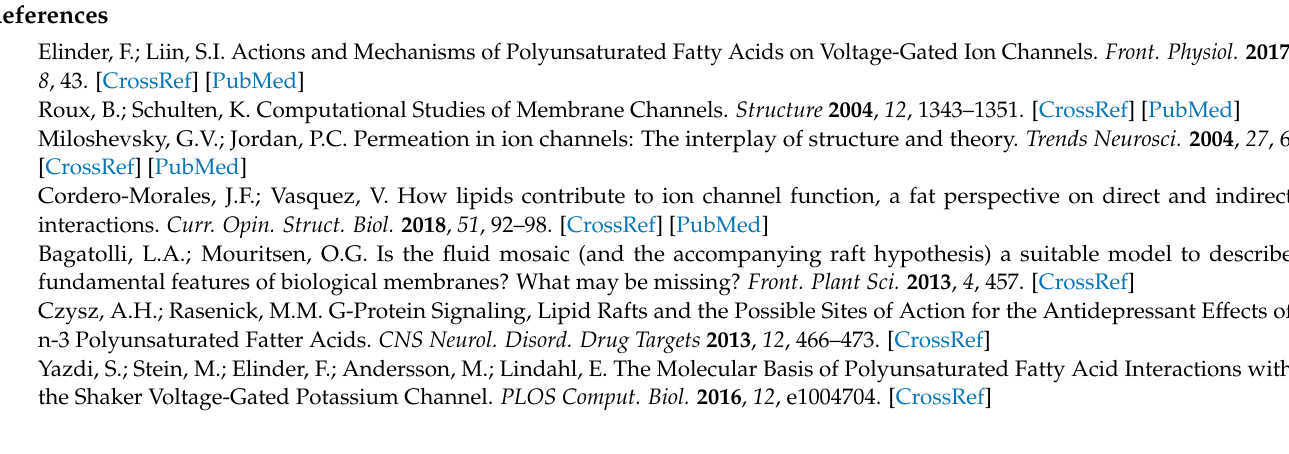
Figure A3. ( a ) Force between two K + ions as a function of distance. This is a pure repulsive Coulomb force. Since each K + carries +1 q0, the repulsion is so strong that an energy of 5.22 eV, or almost 200 k B T at 310 K, would be required for the two charges to approach each other to a center-center distance of 0.276 nm, where theoretically additional repulsion due to overlap of electron shells should set in. Such a close approach practically never happens at this temperature, and therefore no additional repulsive force had to be taken into account. ( b ): The force between two water molecules depends on their relative orientation and on their distance. Here, we show the case where the negatively charged oxygen of one molecule points to one of the positively charged hydrogens of the other molecule. The resulting attractive force pulls the two molecules together until they enter the hydrogen bond. Any closer approach would cause a strong repulsive force.